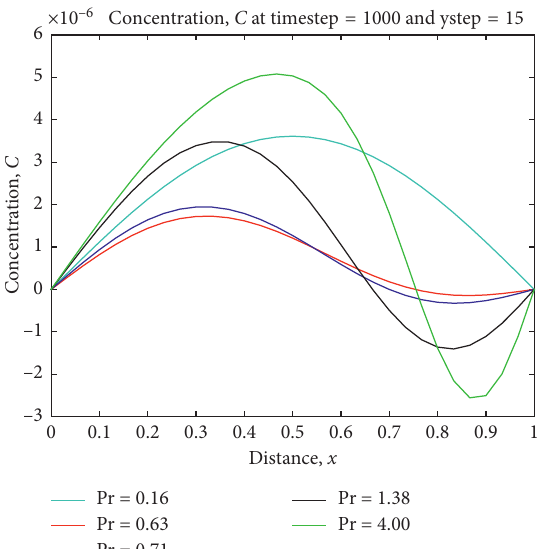
Figure 7: Graph of effects of the Prandt number on concentration profile C